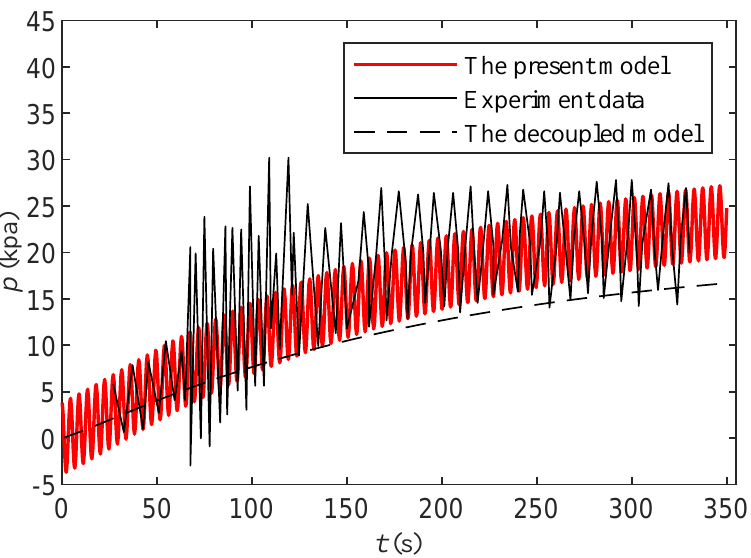
Figure 6. Comparison of the pore pressure at a depth of 2.5 m below the seabed surface between the experimental data [33], the present coupled model and the decouple model